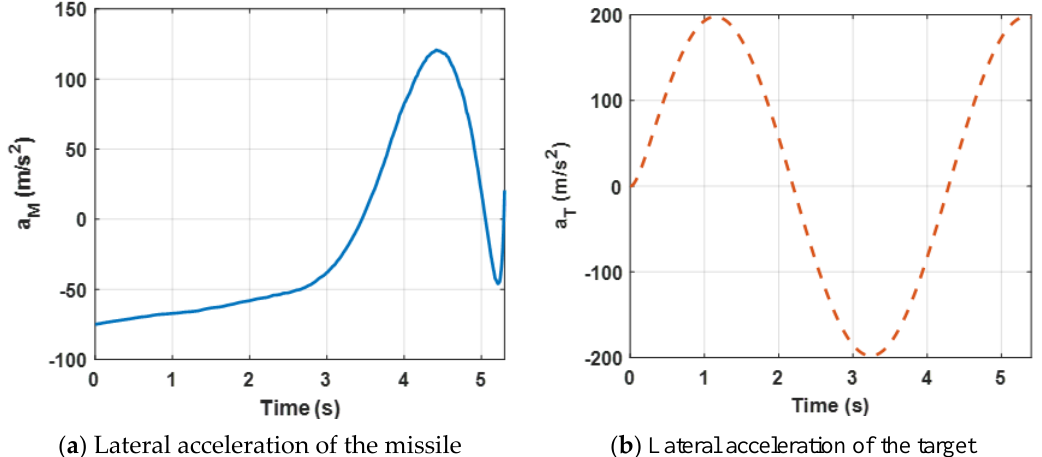
Figure 8. Acceleration demand of the missile and the target for a maneuvering target.